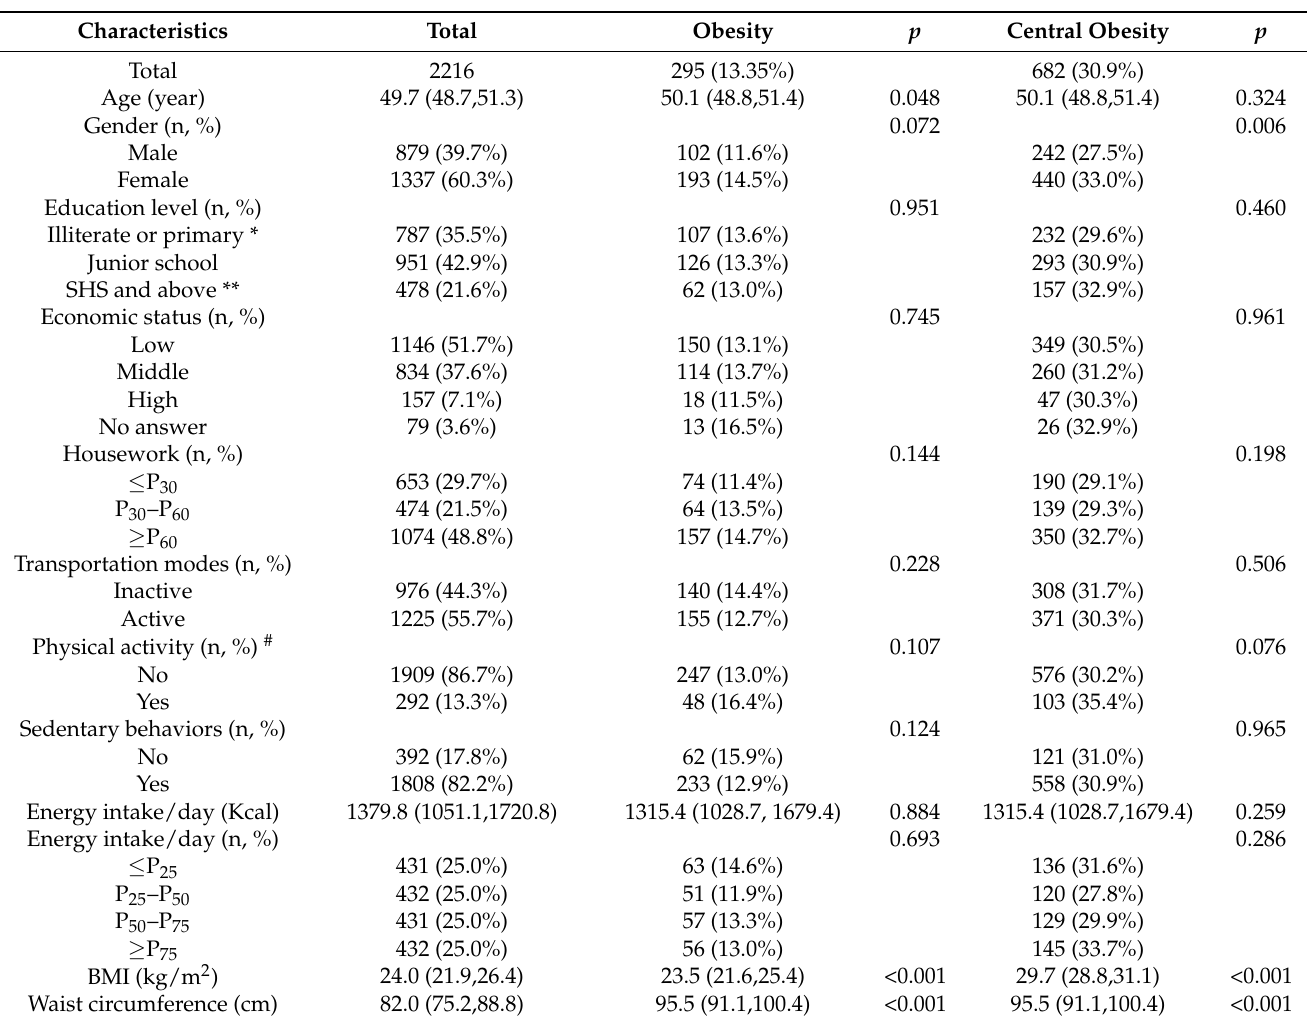
Table 1. Basic characteristics of the 2216 study